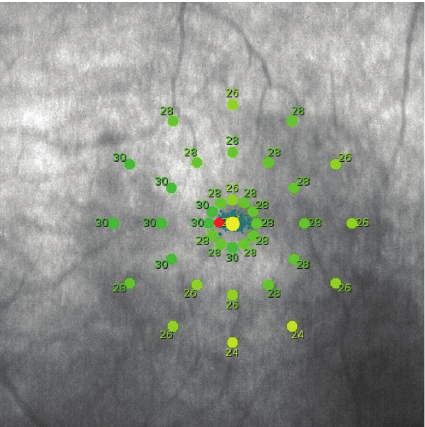
Figure 2: Each colored dot indicates retinal threshold sensitivity (case 8). We chose a region within the 2-degree ring that had the highest potential retinal sensitivity and set the new PRT (red dot) within that